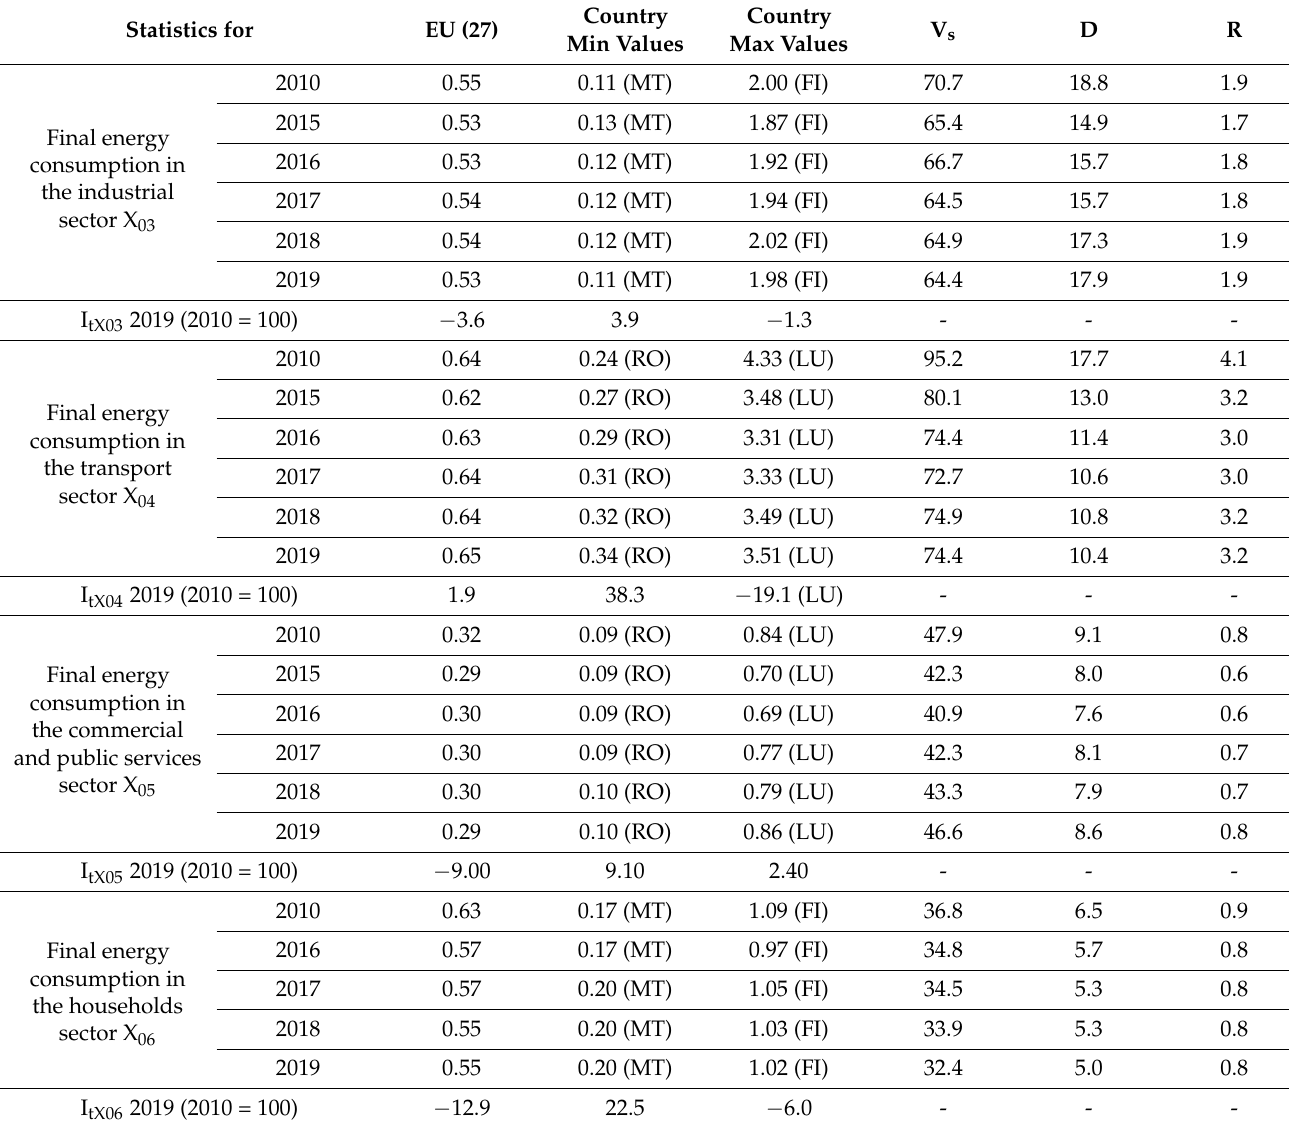
Table 3. Final energy consumption in the industrial (X 03 ), transport (X 04 ), commercial and public services (X 05 ) and households (X 06 ) sector in EU (27) countries in